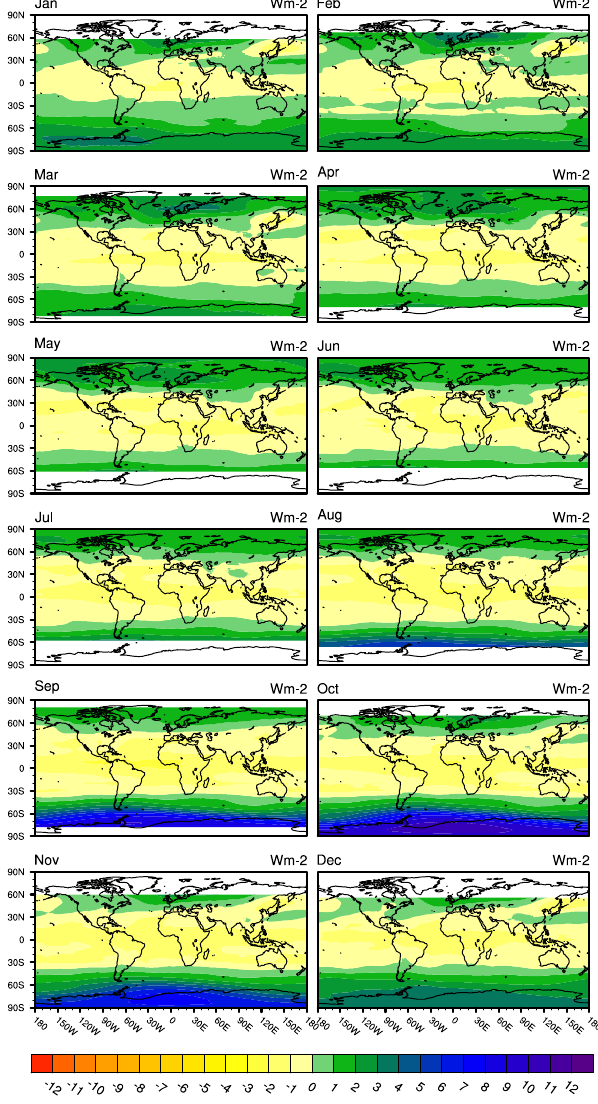
Figure 10. Bias in the ozone absorption using the MSR monthly averages for the period (1979–2008) as a baseline for